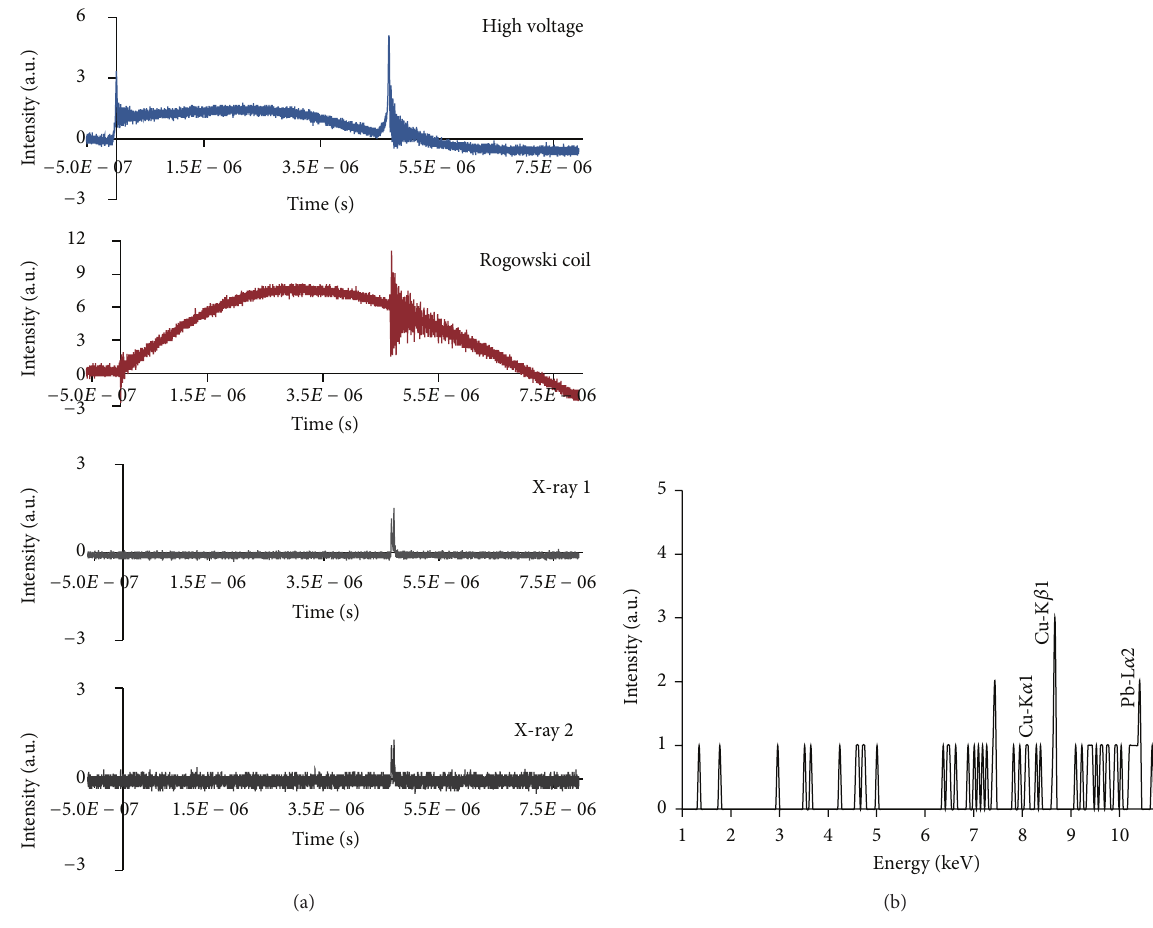
Figure 9: (a) Temporal evolution of X-ray pulses with Al foil thickness for pressure 1.7 mbar, X-ray 1 (23 𝜇 m aluminized Mylar plus 30 𝜇 m Al foil) and X-ray 2 (23 𝜇 m aluminized Mylar plus 20 𝜇 m Al foil) with typical high voltage and Rogowski coil signal. (b) X-ray spectrum: X-ray produced by electron beam-target effect when spectrometer is at top-on position.